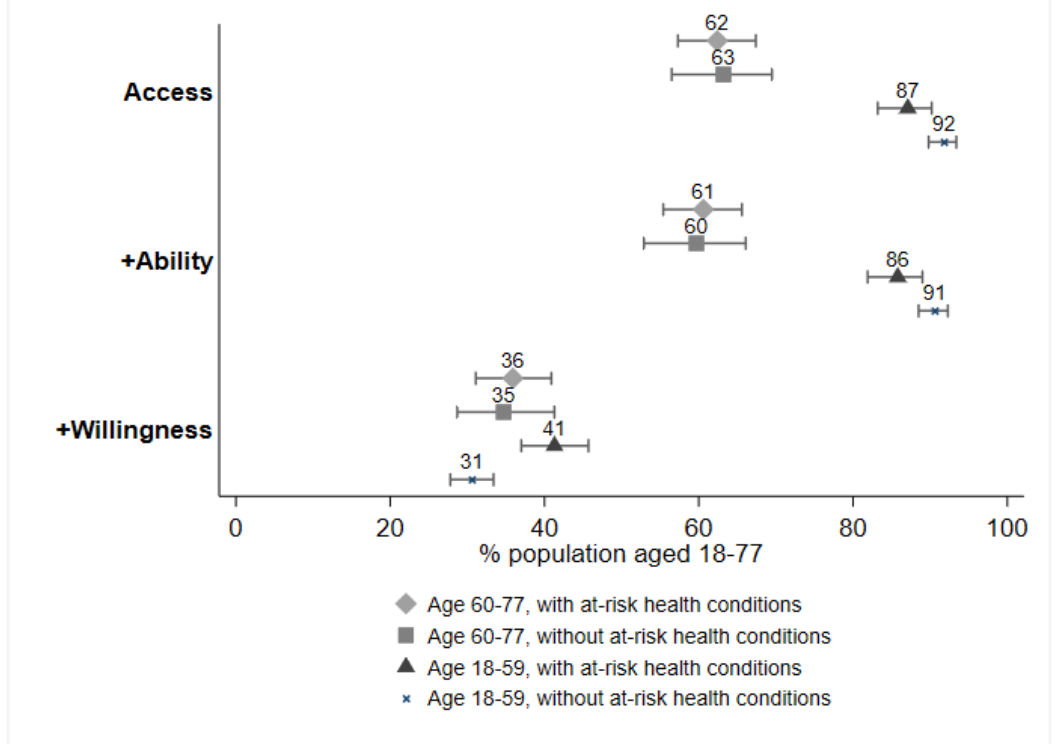
Figure 3. Predicted adoption rates by potential vulnerability to COVID-19 (access: N=3270; ability: N=3270; willingness: N=3269). Error bars represent 95%